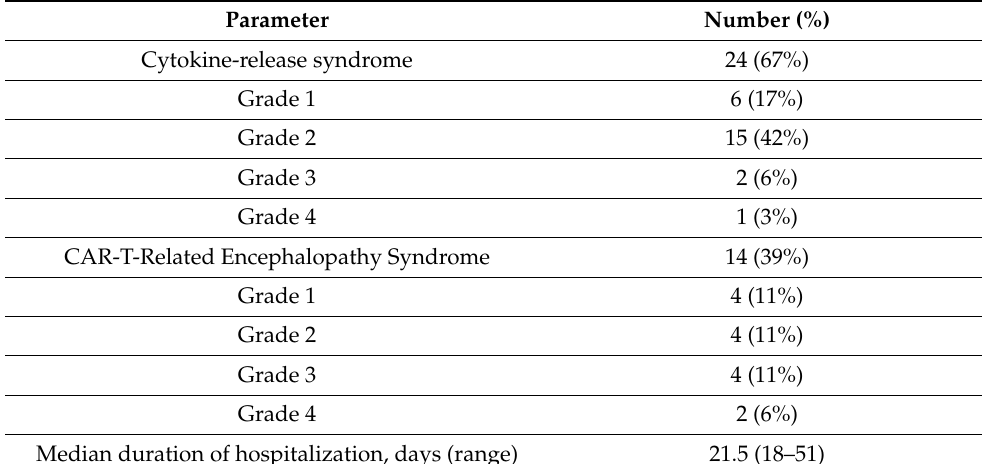
Table 3. Clinical course after CAR-T-cell